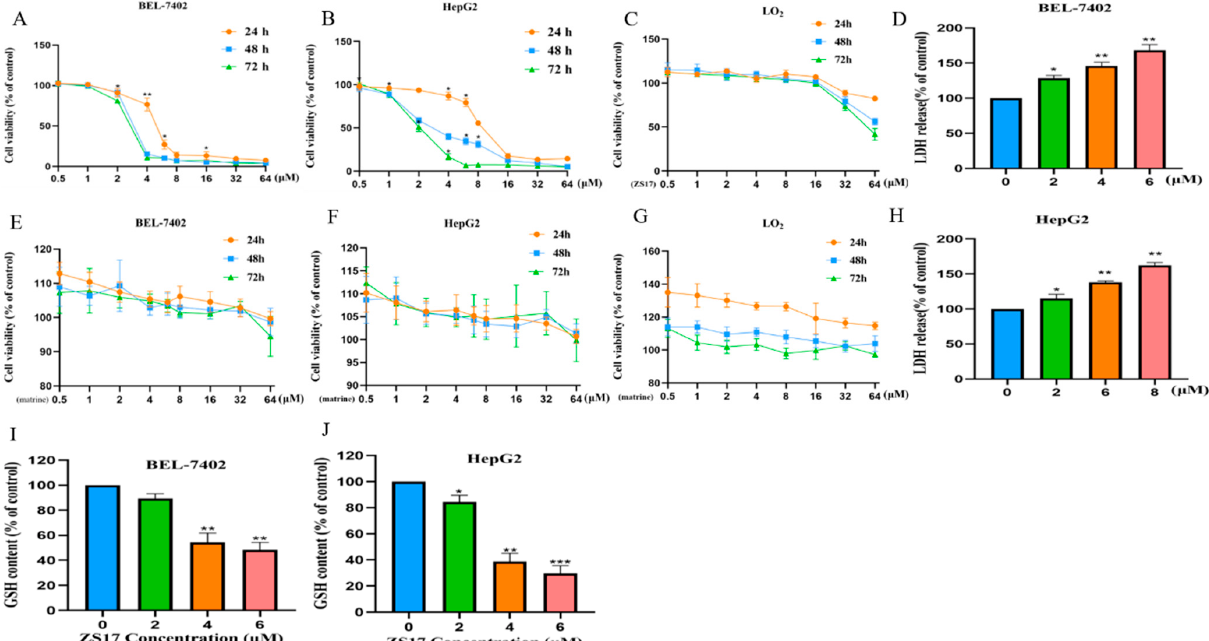
Figure 2. ( A – C ) Liver cancer cells (BEL-7402 and HepG2) and normal human liver cells (LO2) were treated with ZS17 (0, 2, 4, 6 μ M) for 24, 48, and 72 h. Cell viability was measured by MTT assay. ( E – G ) Liver cancer cells and normal human liver cells were treated with matrine. ( D , H ) Cells were treated with ZS17 at a series of concentrations for 48 h. Cell cytotoxicity was evaluated using an LDH assay. ( I , J ) Percentage of GSH in cells after incubation with different concentrations of ZS17 for 48 h. Data are expressed as mean ± SD. Compared with model group: * p < 0.5, ** p < 0.01, *** p < 0.001. n = 3 per group.